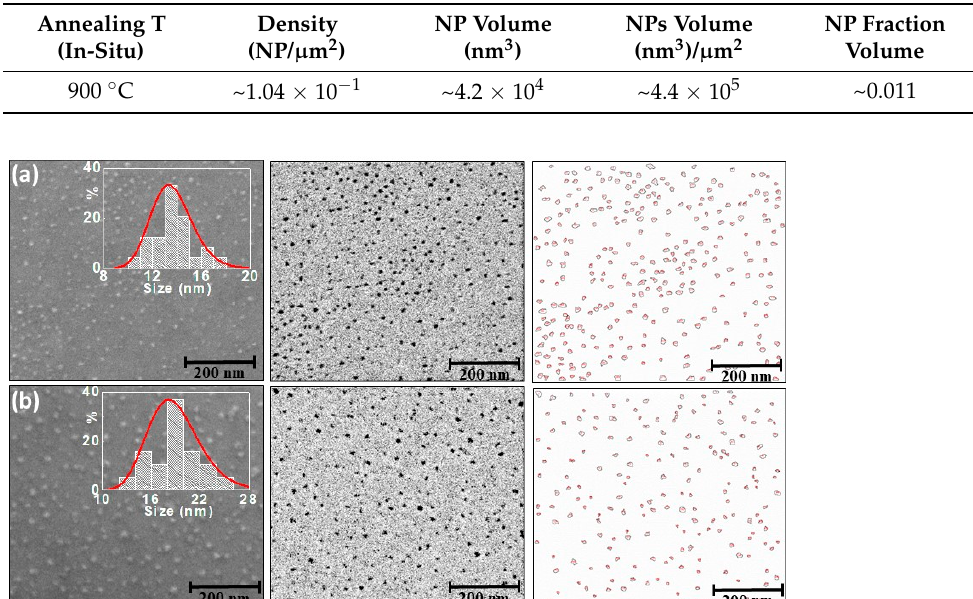
Figure A4. SEM micrograph with a magnification of 50,000 × of LNMO-900 ◦ C thin film (thickness, t = 42 nm, in-situ annealing at 900 ◦ C). Filtered image of its corresponding SEM image ( medium ) and automated grains counting with Image J software ( right ). Table A1. Surface density, average nanoparticle volume, total volume of the nanoparticles (NiO X ) per unit surface (1 µ m 2 ) and nanoparticle fraction volume of LNMO-900 ◦ C thin film (determined from Figure A4).